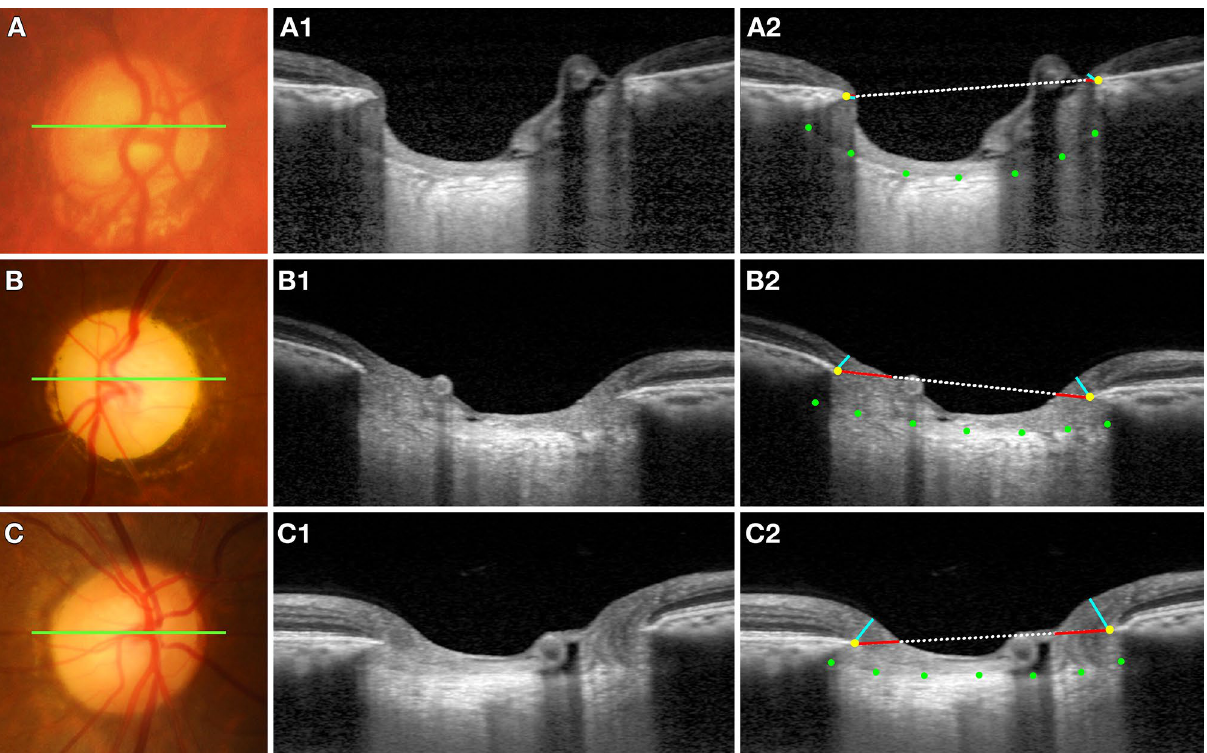
Figure 4. Representative eyes with ( A ) normal tension glaucoma (NTG) and ( B ) central retinal artery occlusion (CRAO), and ( C ) the healthy contralateral eye of the CRAO subject in ( B ). Color disc images ( A – C ), B-scan images in the plane indicated by the green lines in the color disc images ( A1 – C1 ). ( A2–C2 ) are the same images as ( A1 – C1 ) indicating the horizontal rim width (HRW), minimum rim width (MRW), and lamina cribrosa curve. The HRW (red line) was smaller in the NTG eye than in the CRAO and healthy contralateral eyes; MRW (turquoise line) was largest in the healthy contralateral eye followed by the CRAO and NTG eyes; and the degree of posterior bowing of the anterior lamina cribrosa surface (green dots) was greatest in the NTG